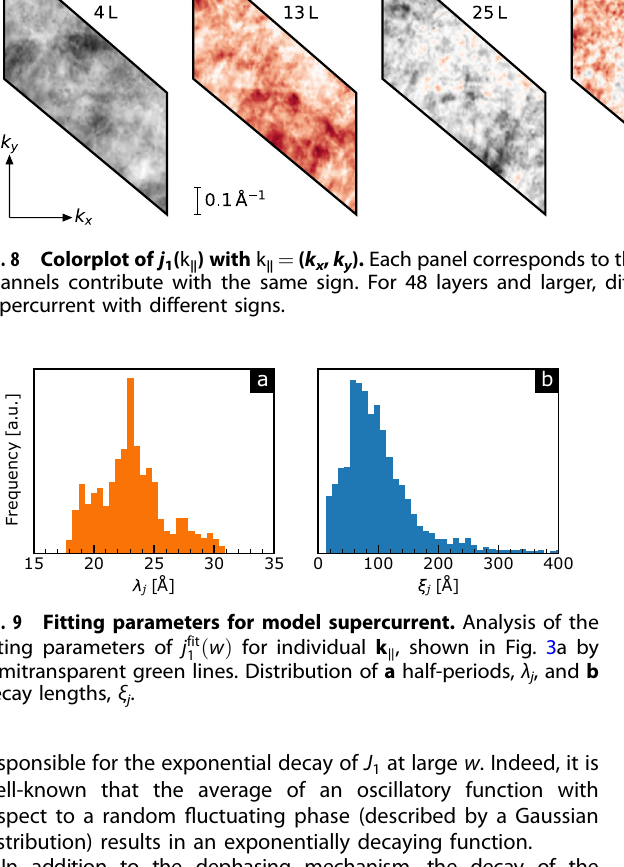
Fig. 7 First Fourier harmonic, J 1 , of the supercurrent as a function of junction thickness, w . Full black circles correspond to J 1 calculated with 290 k ∥ -points, empty circles (mostly superposed onto the full black circles) correspond to 4142 k ∥ -points. A solid black line is J fit given by Eq. (6)]. Green semitransparent dashes show J fit correspond to the standard deviation of j 1 ( k ∥ ) with respect to J 1 . The standard deviation is the same for both sets of k ∥ -point indicating that these results are independent of the chosen discretization.